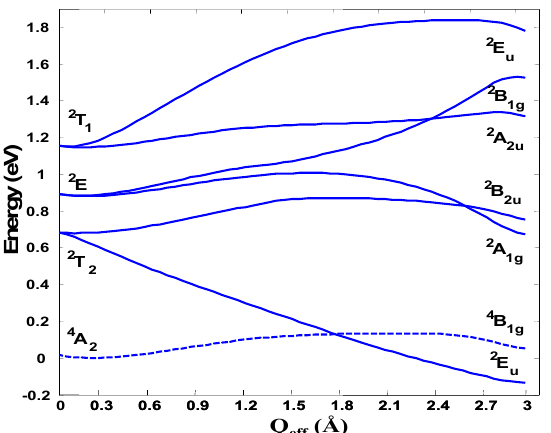
Figure 7. Cross-section of the APES of Na 4 − along the e -mode distortion transforming the system from tetrahedral (Q eff = 0) to square-planar geometry due to the ( T 1 + T 2 ) ⊗ e PJT coupling.